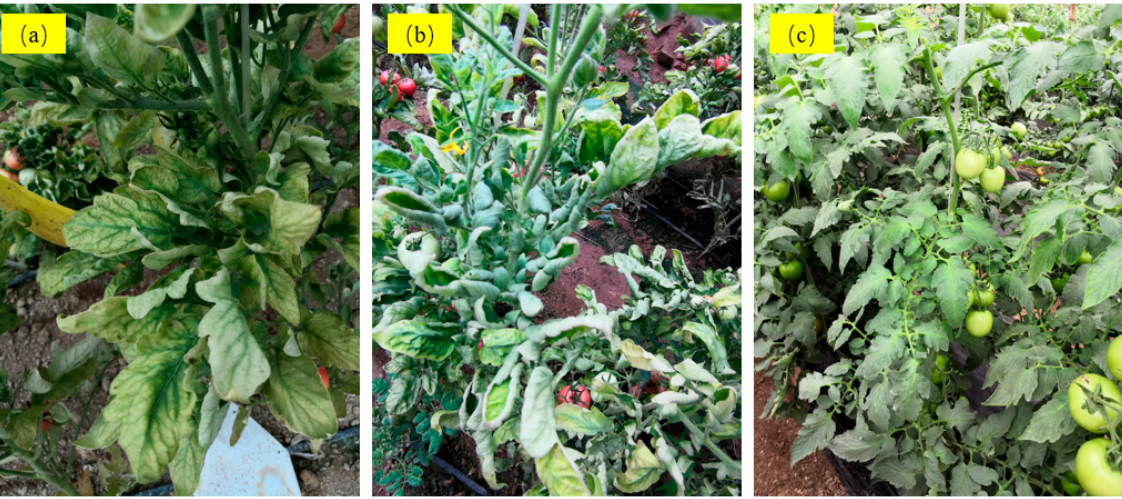
Figure 2. Comparison of diseased leaves ( a , b ) in the 2019SU season and normal growth leaves ( c ) in the 2019AW season. Table 1. Leaf area index (LAI), plant height, and total marketable fresh yield in each tomato growth season.